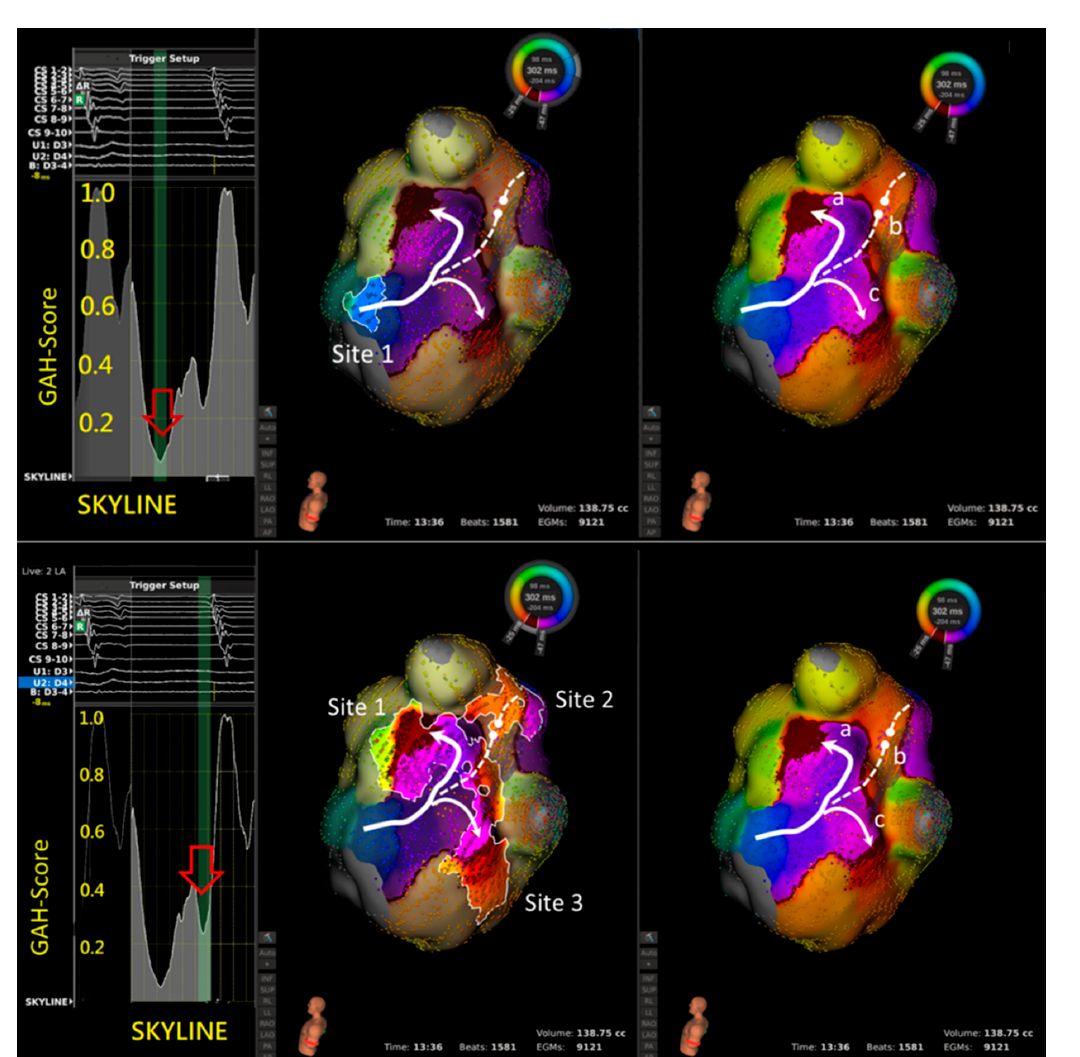
Figure 3. A case of multiple-loop (figure-of-eight) macro-reentry aAFL. Right panel shows wave-front propagating through a slow conduction region at the lateral mitral annulus before diverging into three different activation wave-fronts; critical slow conduction along with LSPV ridge ( a ), wave-front collision ( b ), and another region of slow conduction along the LIPV ridge ( c